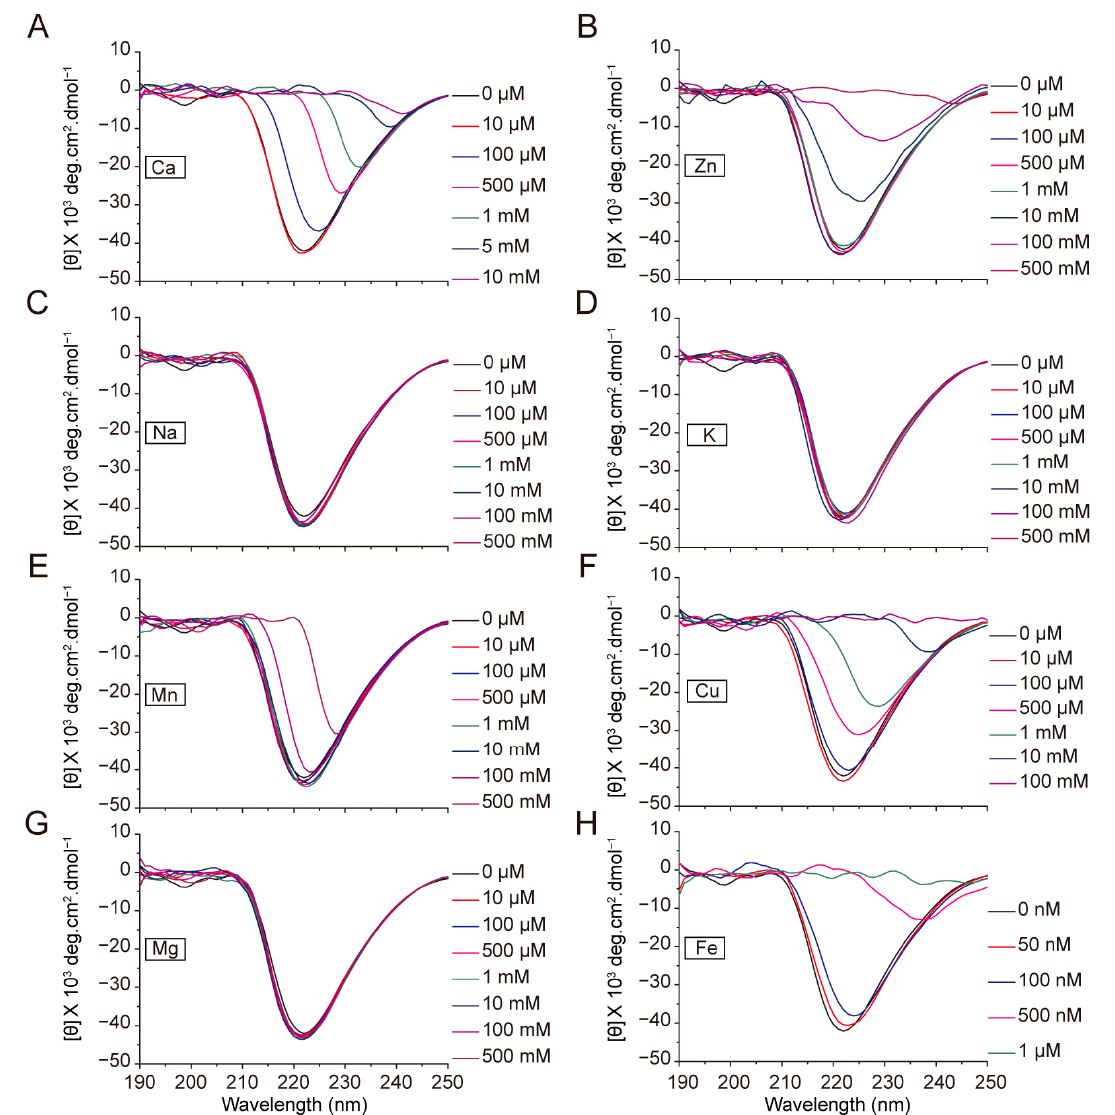
Figure 6. Effect of metal ions on the conformation of RS. ( A – H ): Circular dichroism spectra of 0.25 mg/mL regenerated sericin (RS) solution with different concentrations of metal ions.